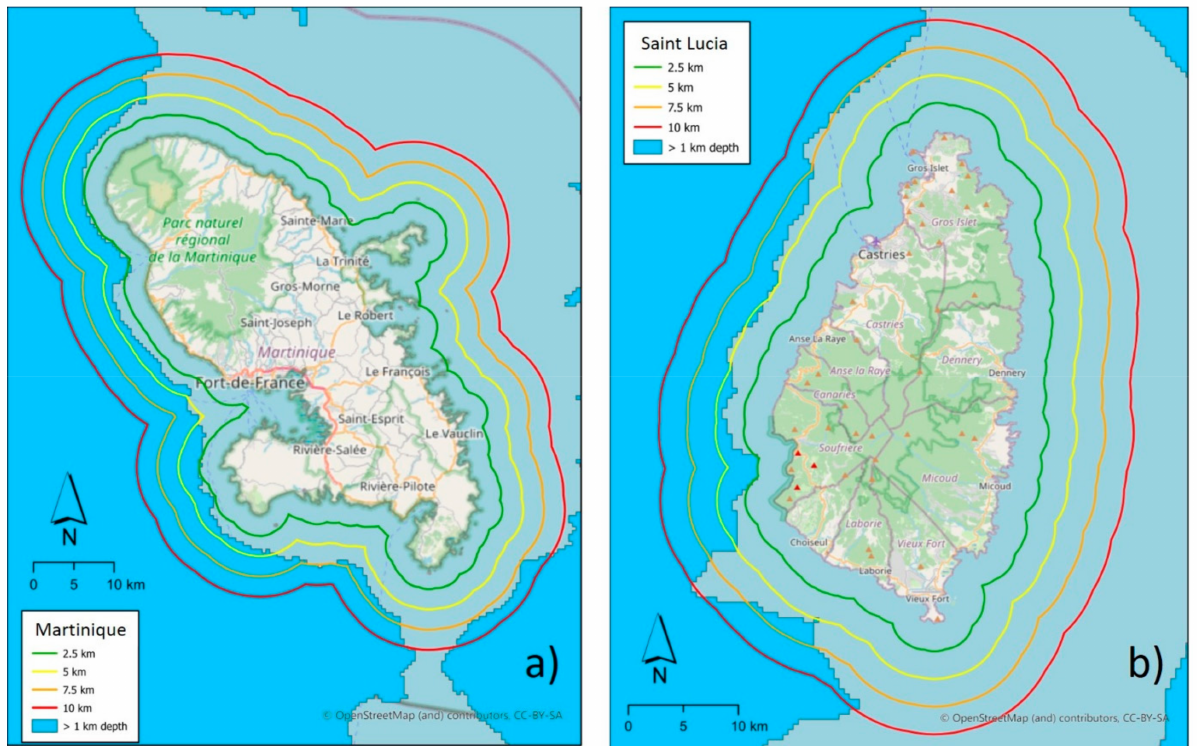
Figure 3. Maps of two example countries in the Lesser Antilles, ( a ) Martinique and ( b ) Saint Lucia. Bathymetry contour (gray/blue) represents the boundary between depths of greater than and less than 1000 m. Other contours are equidistant from the coast at 2.5 km (green), 5.0 km (yellow), 7.5 km (orange) and 10 km (red).